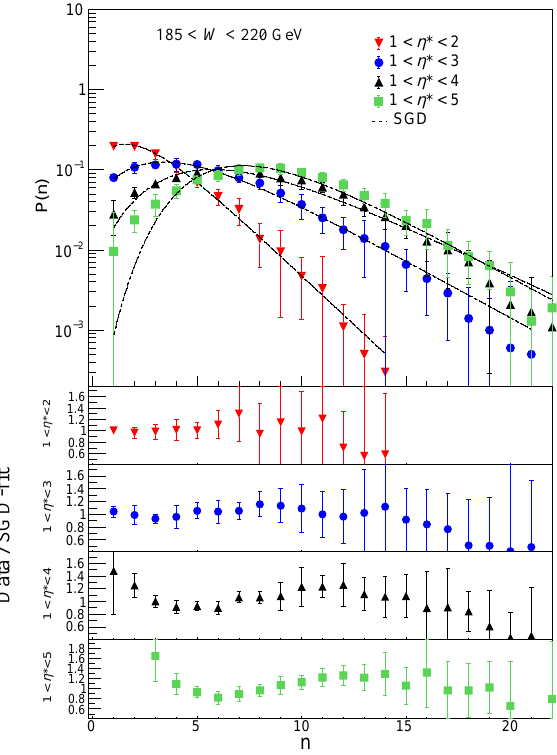
Figure 5. Multiplicity distributions for SGD fits to the data [33] in different η ∗ ranges for 185 < W (GeV) < 220. The lower panel shows the data/SGD-fit ratio plots for different η ∗